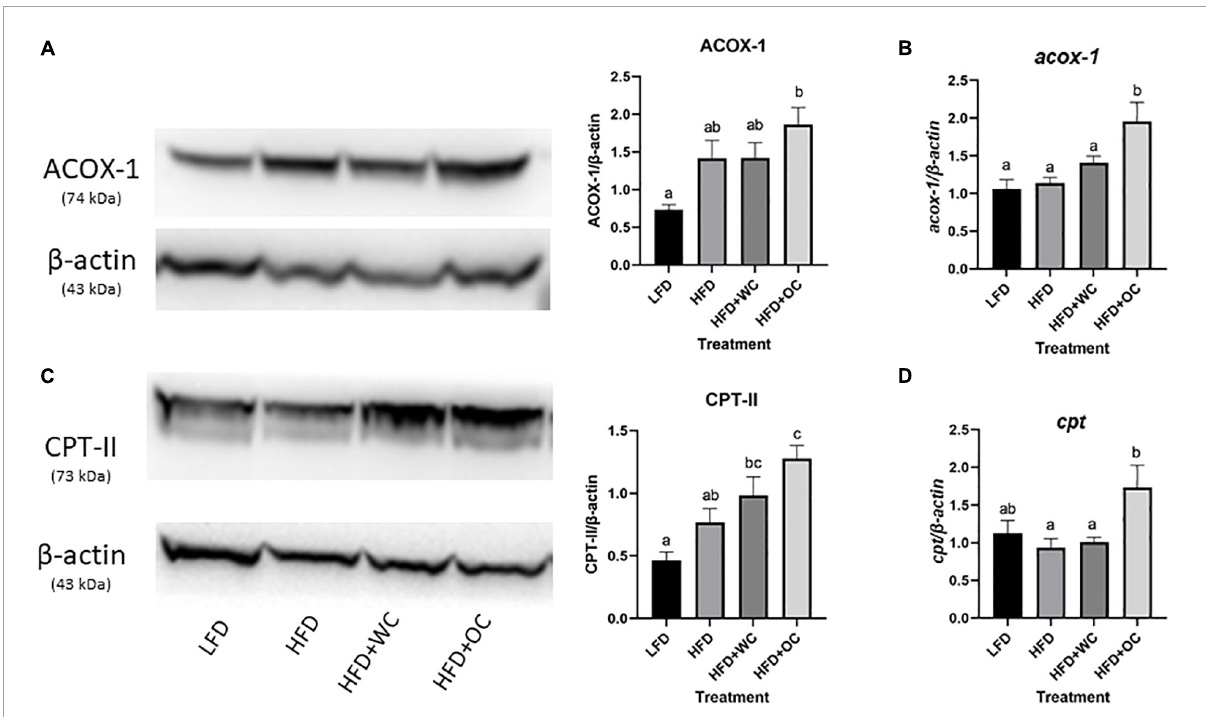
FIGURE5 Carotenoids in HFD + OC diet promote hepatic β -oxidation. Western blot of (A) ACOX-1 and (C) CPT-II protein expression; performed with 4–12% Bis-Tris gels; graphical changes between the dietary groups. Changes in mRNA levels in hepatic (B) acox-1 and (D) cpt generated via qPCR. For both western blot and qPCR, LFD: n = 11; HFD, HFD + WC, HFD + OC: n = 12. The fold change of mRNA and protein levels were analyzed by one-way ANOVA with post hoc Tukey HSD. Letter differences indicate statistical significance ( p < 0.05).